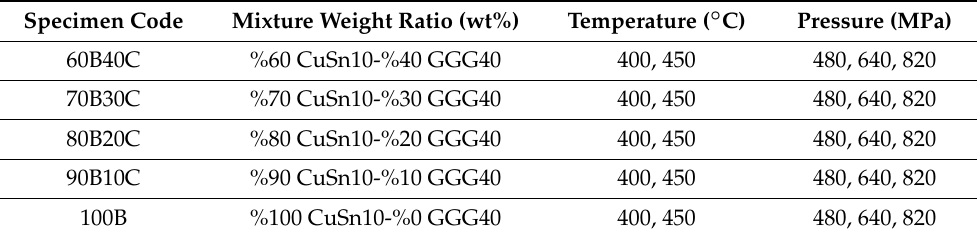
Table 2. Composite material production